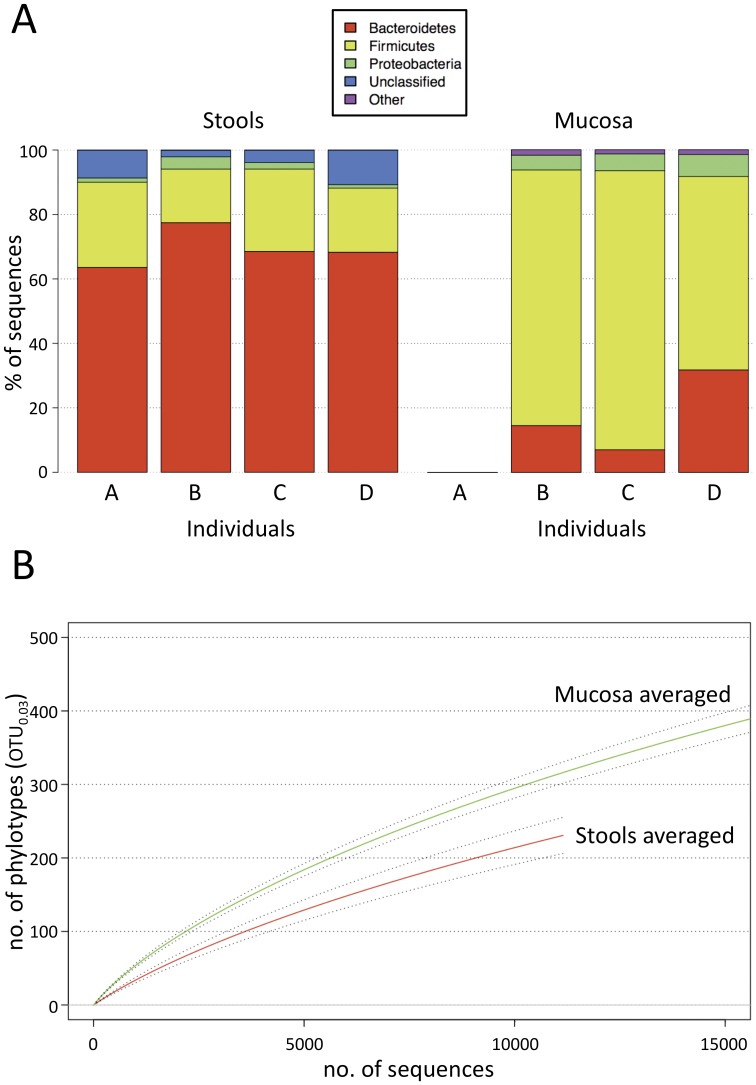
Different community structure and richness in stool and mucosa specimens.(A) Relative phylum distribution in stool (individual A, B, C, D) and mucosa specimens (individual B, C, D) from pooled data from each individual. “Unclassified” denotes phylotypes that were only assigned to the bacterial domain by using the 80% identity threshold for RDP classifications. “Other” denotes phyla prevalent below 2%. (B) Rarefaction analysis of averaged mucosa (green) and stool (red) samples (OTU distance = 0.03). The dotted line indicates ± SEM.